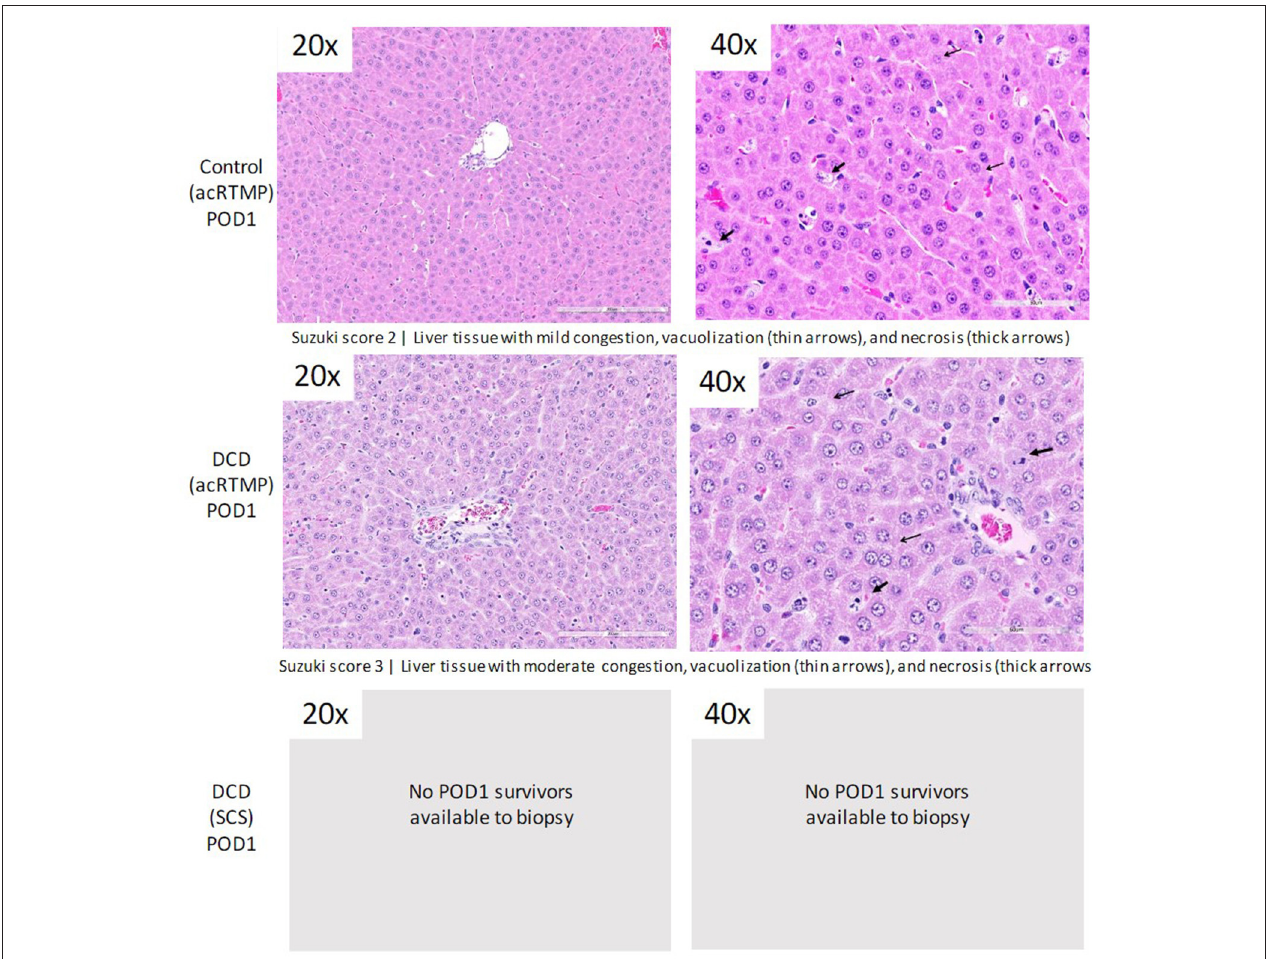
FIGURE 10 | Higher magnification of graft histologic injury by Suzuki score at study